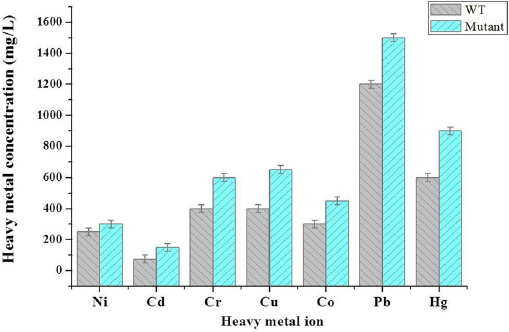
Figure 4. The resistance to different concentrations of heavy metal of isolates of Aureobasidium strain wild-type AP and modified mutant strain AP T ∆ A . Each error bar indicates + / − one standard error of the mean.